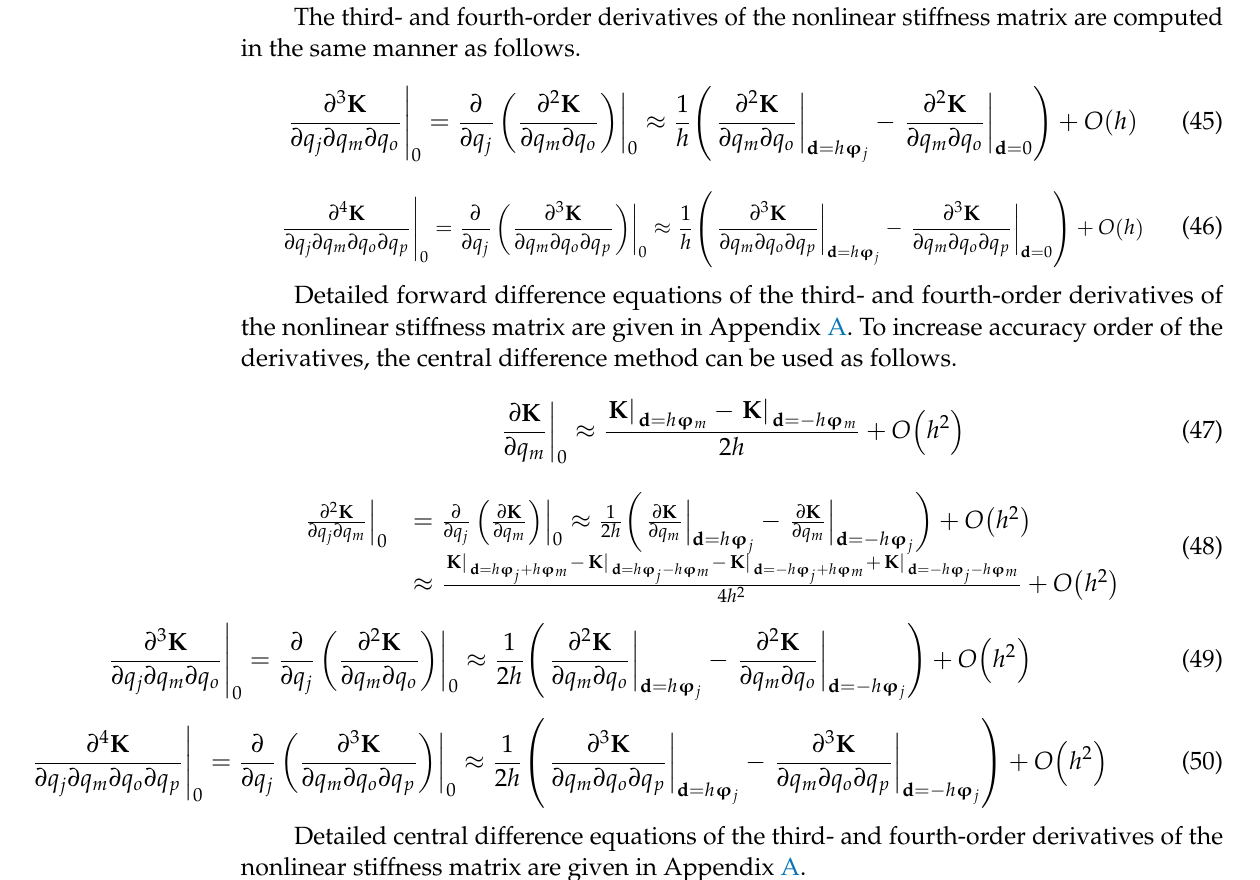
The third- and fourth-order derivatives of the nonlinear stiffness matrix are computed